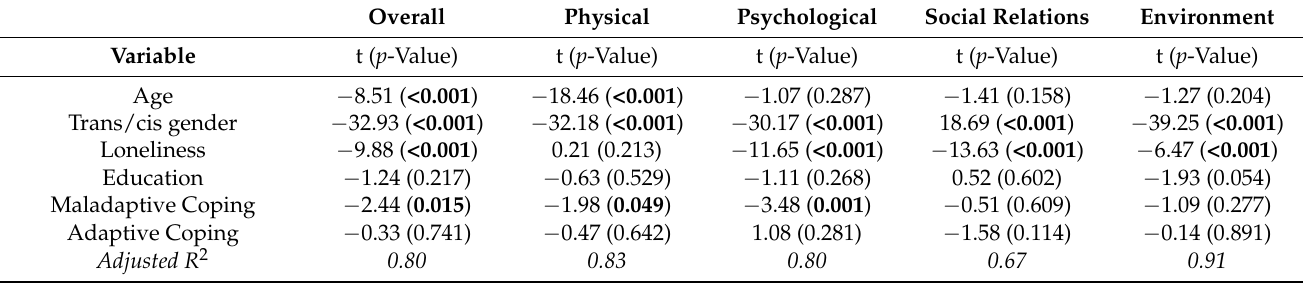
Table 4. Regressions on overall QoL and four QoL subscales for transgender and cisgender participants